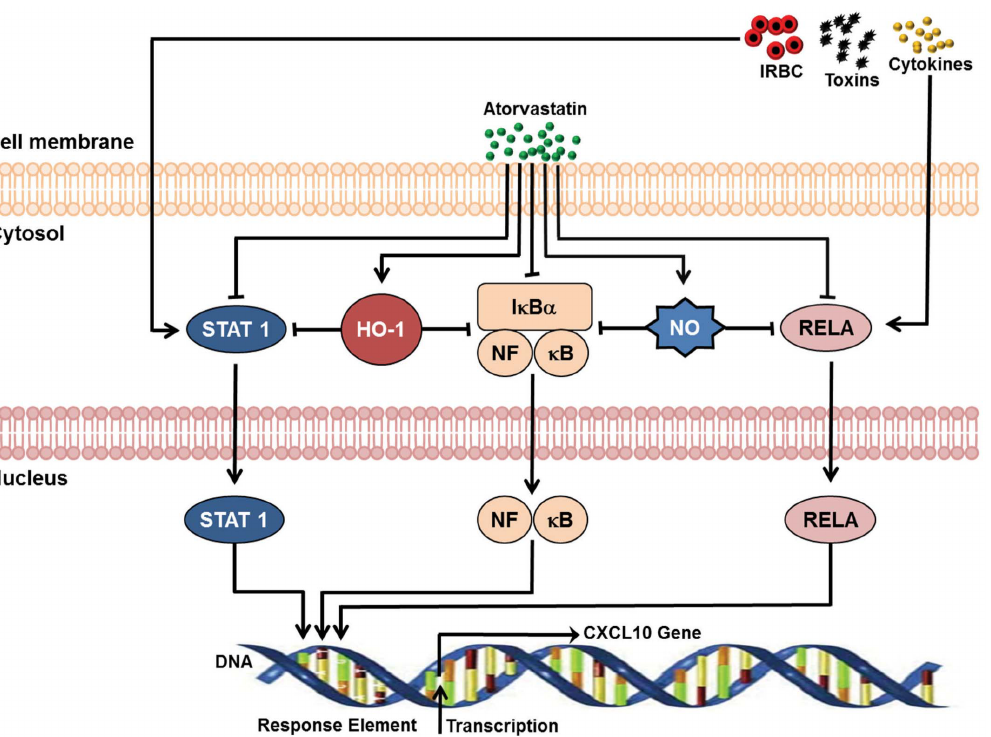
Figure 6. Schematic model of signaling pathways ATV utilize to modulate the expression of CXCL10 identified by Ingenuity Pathway Analysis. In response to various stimulus, transcription factors, STAT1, NF k B, and RELA, are activated resulting in the transcription of CXCL10 gene to mRNA [57–64]. Atorvastatin inhibit activation of RELA (NF k B3/p65) [56,57], NF k B complex [58,59] and STAT1 [59]. Atorvastatin increases expression of HO-1 [68] which inhibit activation of NF k B complex [69], STAT1 [70] as well as expression of CXCL10 [71]. Atorvastatin stimulates production of nitric oxide (NO) [72], which inhibit active NF k B/p65 and NF k B complex [73–76]. ATV=atorvastatin; IRBC=infected red blood cells; HO-1=heme oxygenase-1; NO=nitric oxide; RELA=v-rel reticuloendotheliosis viral oncogene homolog A (avian); NF k B=nuclear factor of